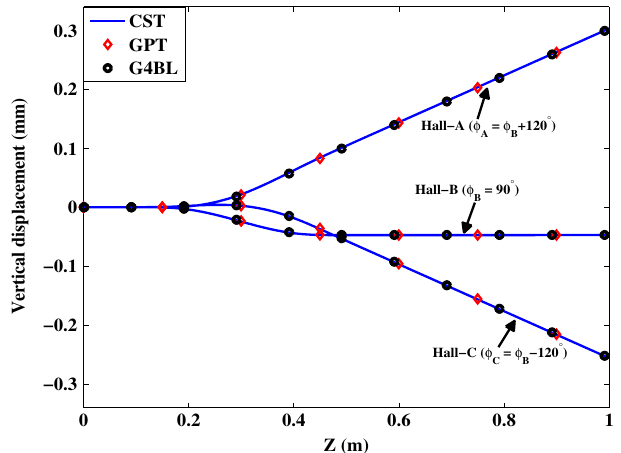
FIG. 8. Comparison of vertical displacement results using CST PARTICLE TRACKER , GPT , and G4BEAMLINE computer codes. Parameters chosen are the same as in Fig.